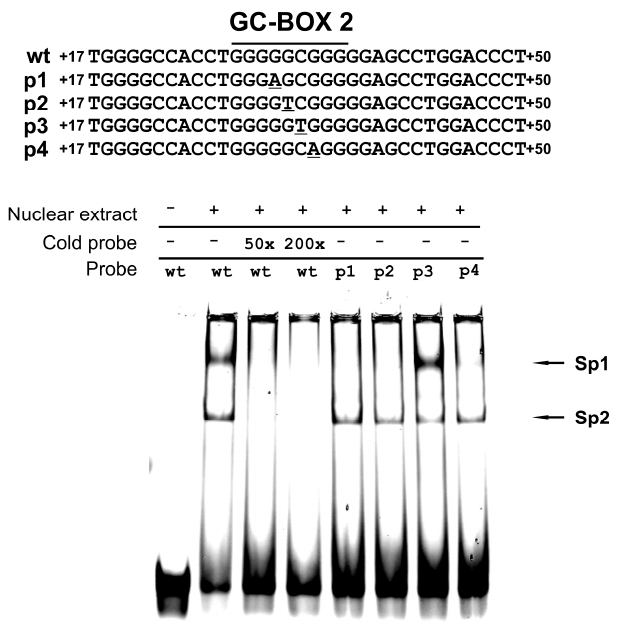
Figure 3. Effect of polymorphisms of GC-box2 on Sp protein binding demonstrated by the electrophoretic mobility shift assay (EMSA).